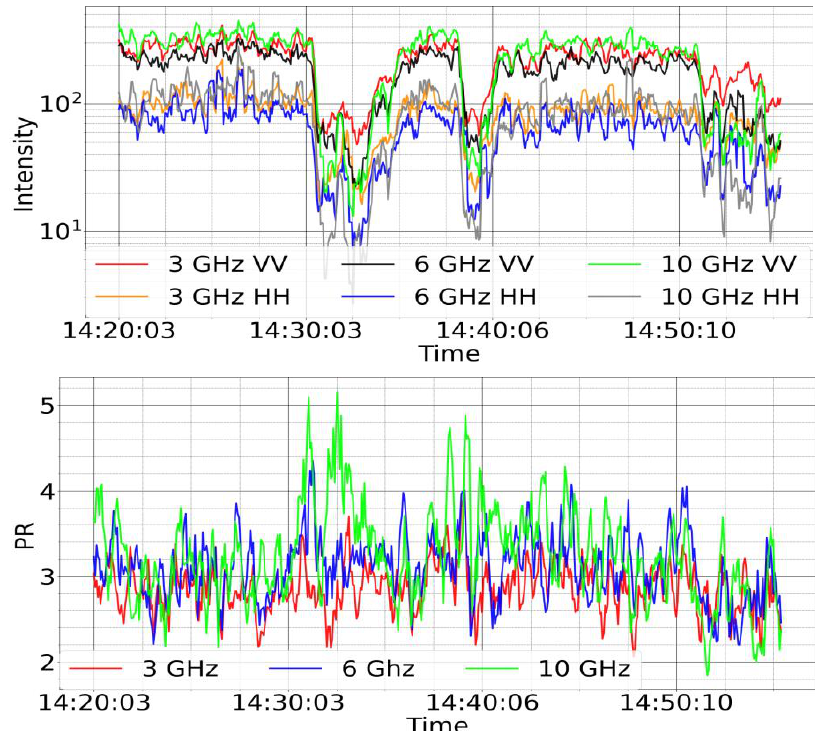
Figure 2. An example of radar backscatter time series in different radar bands and at VV and HH-polarizations and corresponding polarization ratio. Upwind observation.